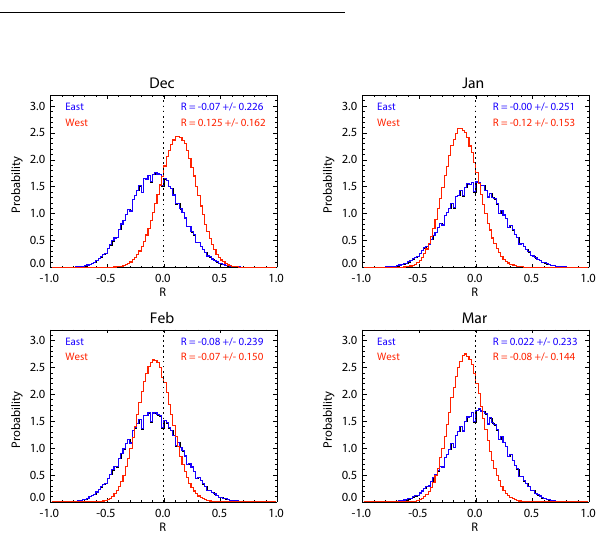
Fig. 6. Monte Carlo sampling plots showing the normalized proba- bility of R between the 30hPa geopotential heights at the North Pole and the 255nm spectral irradiance for December, January, February, and March as a function of QBO east (blue) and west (red) from the combined WACCM4 simulations. Dotted line represents zero corre- lation and is shown to emphasize the mean change in R . The mean and standard deviation of R for each QBO phase is listed at the top right of each month. A bin width of 0.02 was used to create the